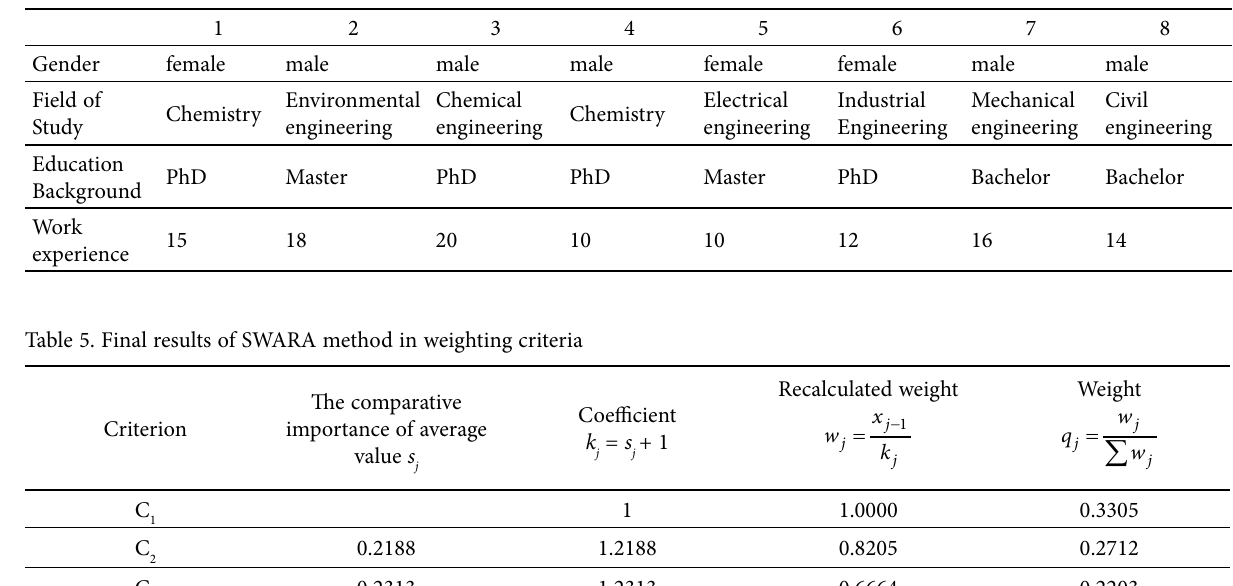
Table 4. Background information of experts